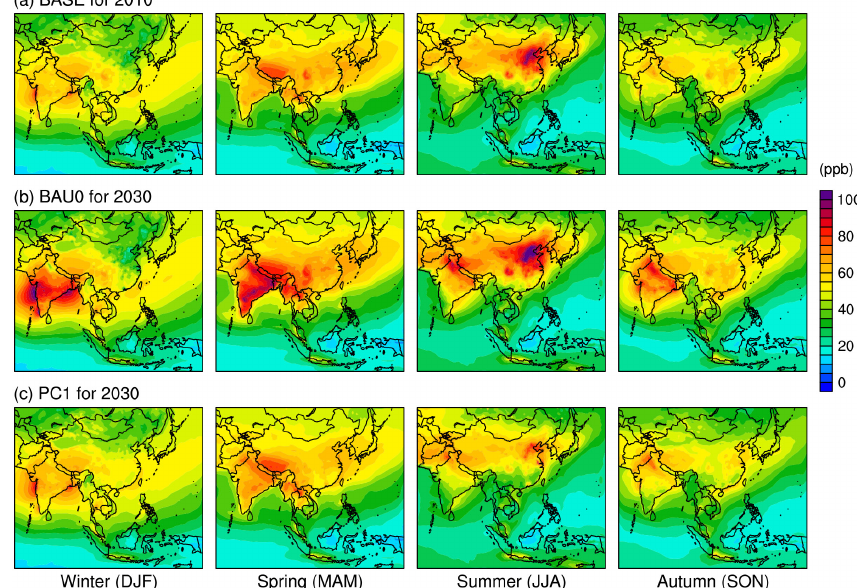
Figure 2. Horizontal distributions of simulated seasonal mean surface ozone concentration in (a) BASE for 2010, (b) BAU0 for 2030, and (c) PC1 for